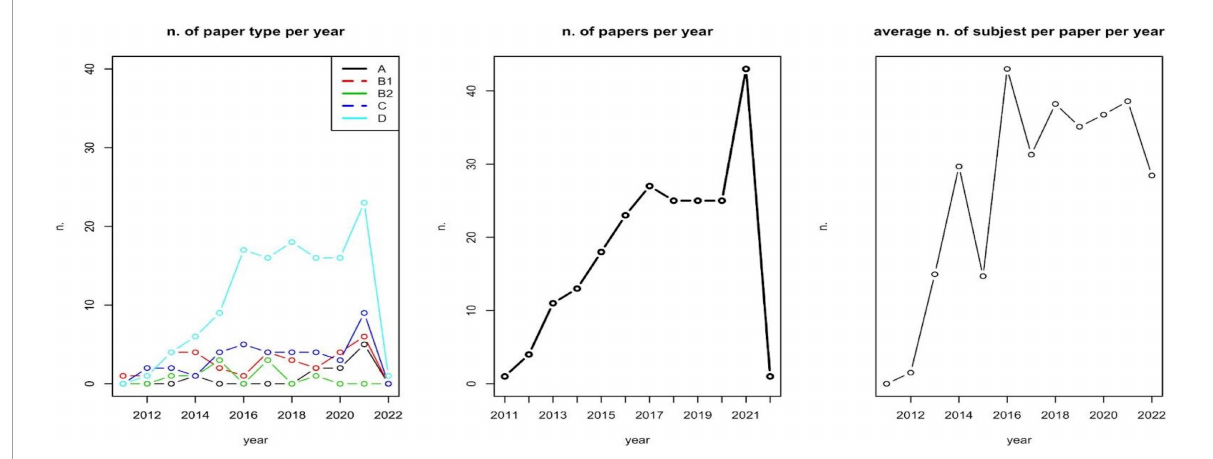
FIGURE2 Papers’ type, no. of papers, and average number of involved subjects per year.